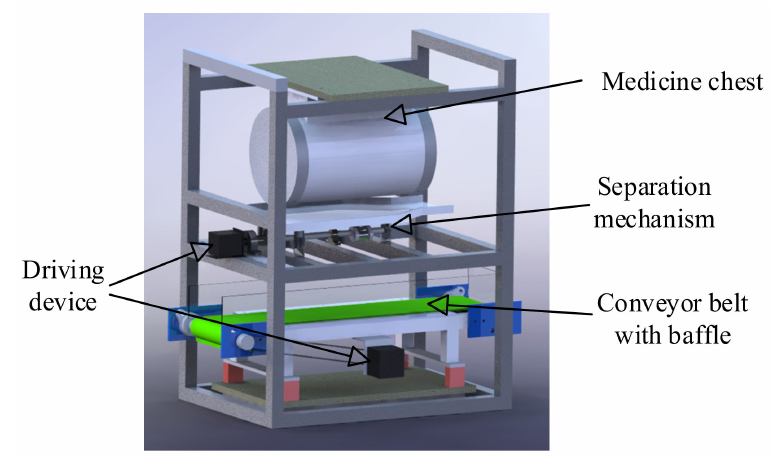
Figure 13. Bulk traditional Chinese medicine dispenser.